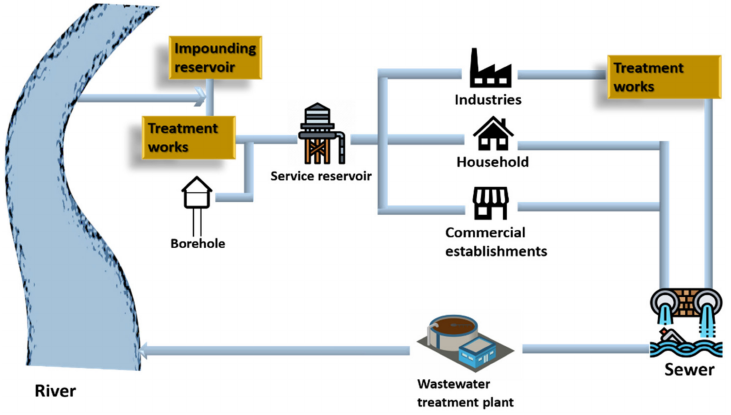
Figure 1. Cycle of water